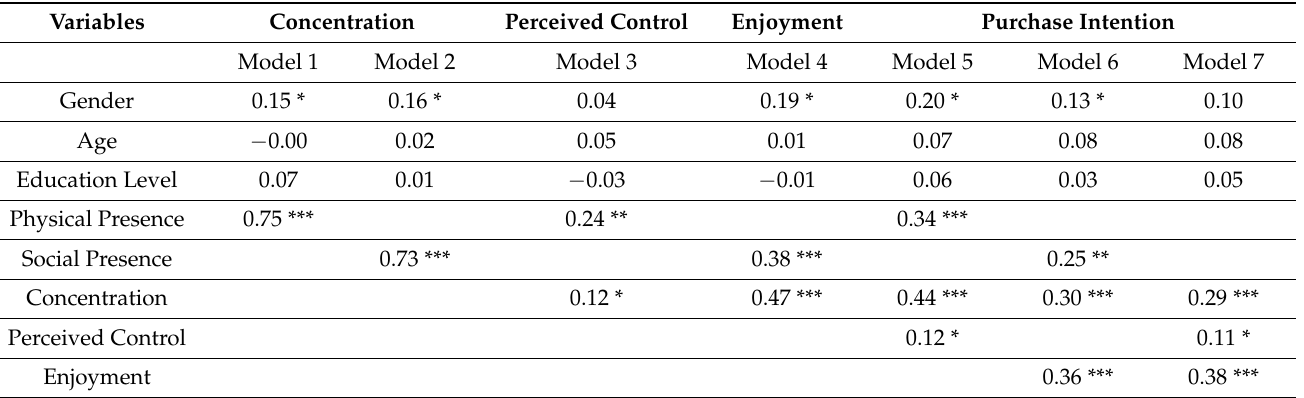
Table 7. Results of regression